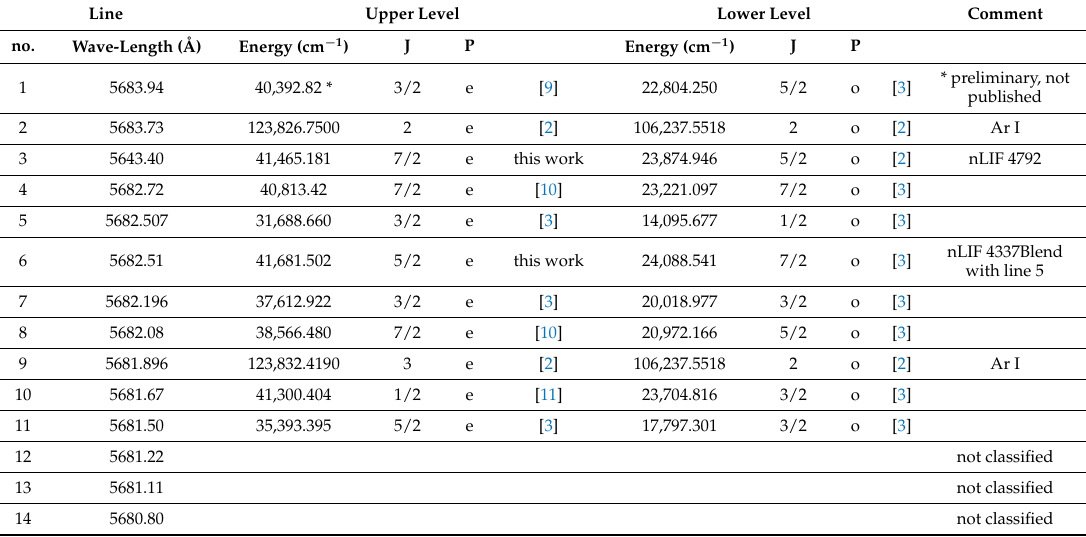
Table 1. Lines shown in Figure 2. nLIF: observation of a “negative” fluorescence line at the given wavelength ( ± 2 Å). Wavelengths in column 2 are either determined from the FT spectrum or measured by the wavemeter. References for the energy levels are also given. Upper Level Lower